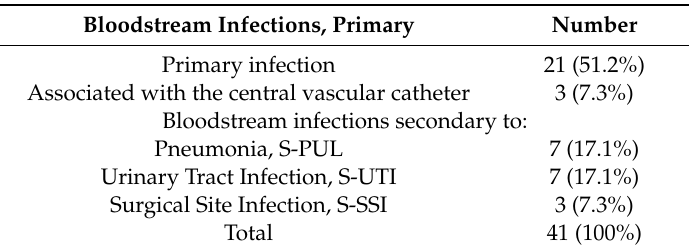
Table 2. Sources of bloodstream